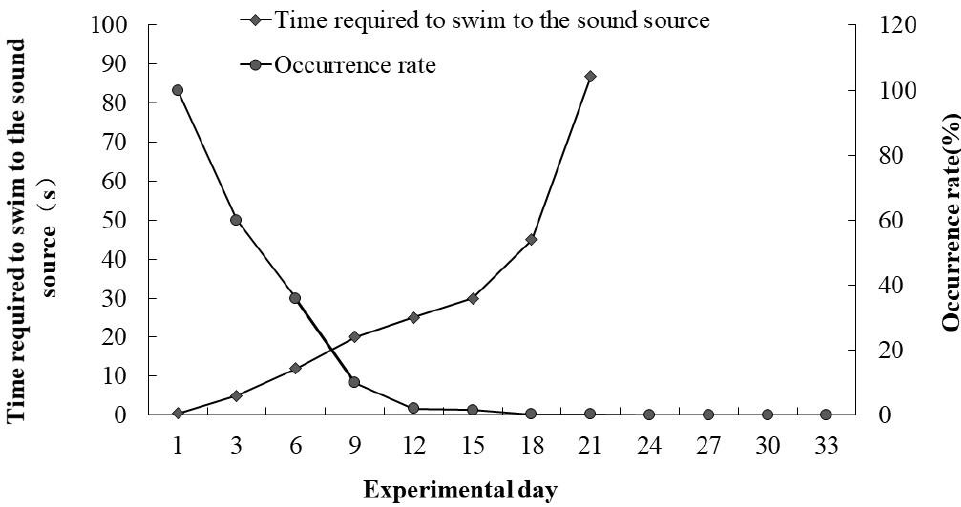
Figure 13. Changes in the time required to swim to the sound source and occurrence rate of juvenile Pagrus major .